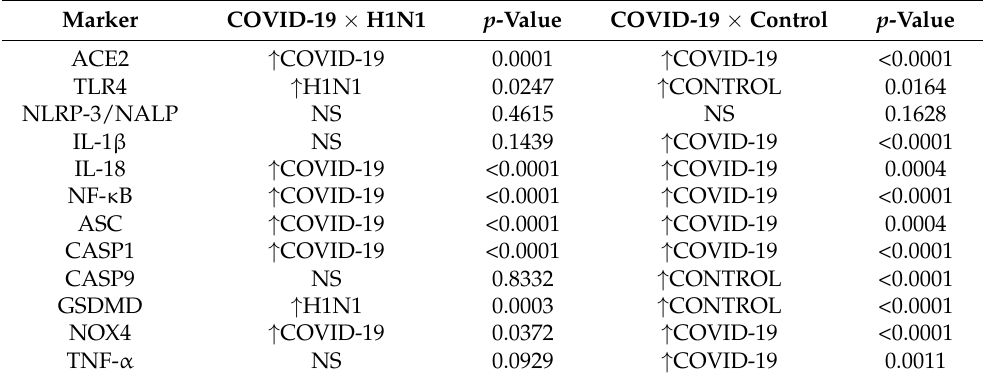
Figure 2. Graphs presenting the comparison between COVID-19, H1N1, and CONTROL groups regarding IL-1 β , CASP1, GSDMD, and CASP9. Panel A shows that IL-1 β is more expressed in COVID-19 than in H1N1 and the control group. In Panel B is possible to see that CASP1 expression is remarkably high in COVID-19, unlike CASP9 (seen in Panel D ) which is significantly less expressed, a difference expected to be seen only within the Pyroptosis context. Panel C shows that GSDMD is being less expressed in COVID-19 than in H1N1 and CONTROL groups. The symbol “*” stands for p ≤ 0.05, “***“ stands for p ≤ 0.001, “****” stands for p ≤ 0.0001 . Slide images were obtained on a 40× augmentation. Image created using biorender.com. Table 2. Results of statistical analysis and immunohistochemical analysis. Column 1 shows the staining analyzed, Column 2 shows the COVID-19 group versus H1N1 comparison, and Column 3 shows the COVID-19 versus CONTROL comparison. Paired marker expression comparison. Arrows pointing upwards indicate augmented expression.